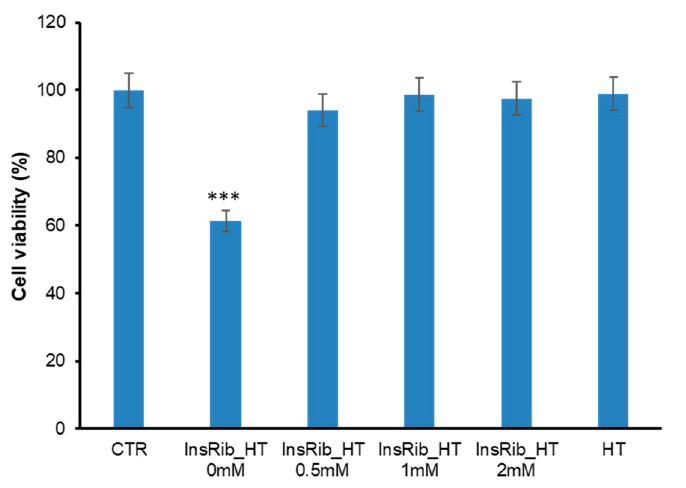
Figure 3. Cytotoxicity of insulin species glycated in the presence of HT. SHSY5Y cells were exposed for 24 h to insulin samples glycated with D -ribose in the presence of different concentrations of HT (0, 0.5, 1, 2 mM) and the cell viability was evaluated by the MTT assay. Data are expressed as average percentage of MTT reduction ±SD relative to control cells from triplicate wells from 5 separate experiments ( p < 0.01). Other experimental details are described in the Methods section. *** p < 0.001 versus CTR.